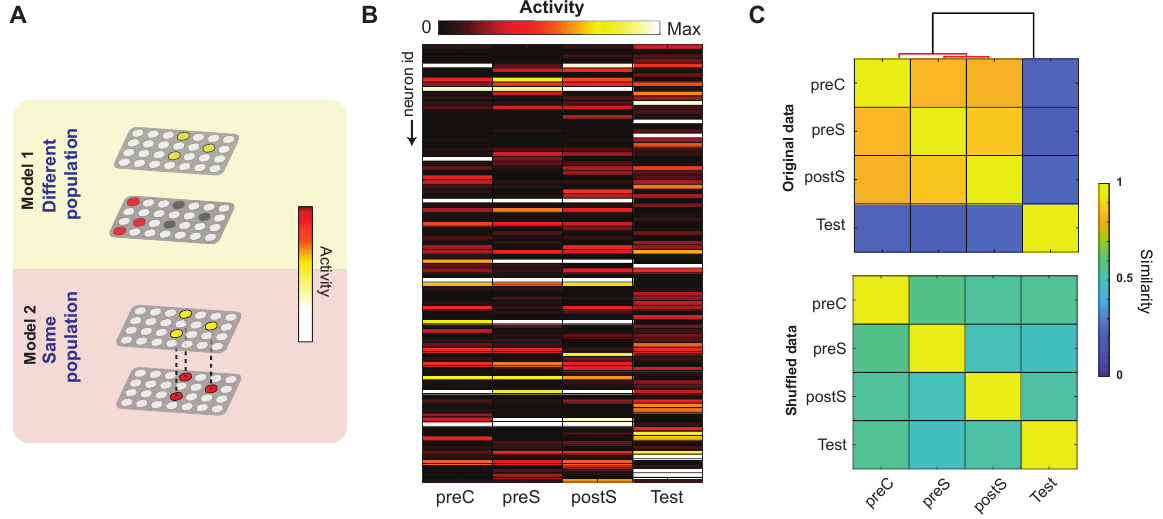
Figure 2. No overlap between ABN populations active during learning versus retrieval. ( A ) Two potential models by which population ABN activity could change between two different periods. ( B ) ABN activity vectors in different periods. Each row represents the mean activity of individual ABNs. Each activity vector was rescaled from 0 to 1. ( C ) Similarity matrix (i.e., cosine similarity) between pairs of activity vectors for the original data (top) and after random shuffling (bottom). The overlaying dendrogram represents the results of hierarchical clustering, with significant clusters ( p < 0.05) shown in red. n = 94 neurons from 4